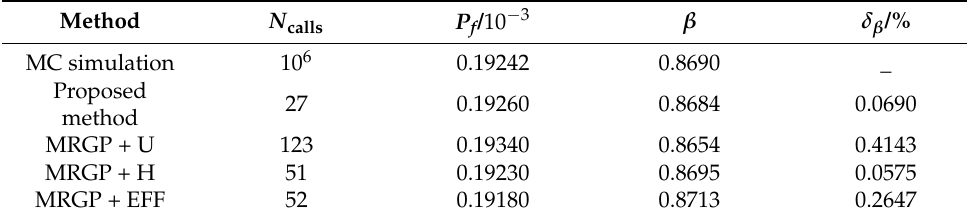
Figure 5. MRGP models and its samples distribution for the parallel system. ( a ) MRGP + U; ( b ) MRGP + H; ( c ) MRGP + EFF; ( d ) Proposed method. Table 2. Results of example 4.3 with different methods.